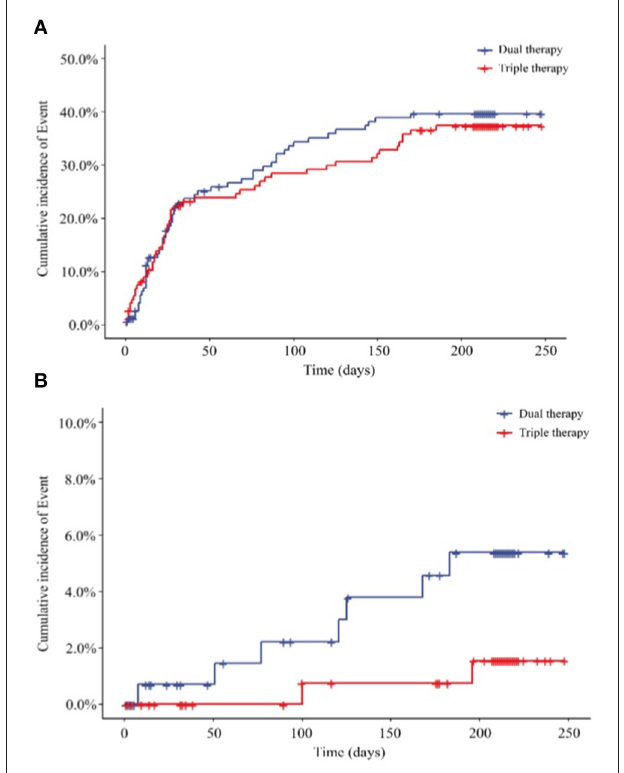
FIGURE 2 | Endpoints, (A) Primary outcome for the incidence of total bleeding (HR 0.930; 95% CI, 0.635 to 1.361; P = 0.7088); (B) secondary outcome for the incidence of major bleeding (HR, 0.273; 95% CI, 0.057 to 1.315; P = 0.1056) HR, hazard ratio. Dual therapy: ticagrelor therapy group; triple therapy: clopidogrel plus aspirin